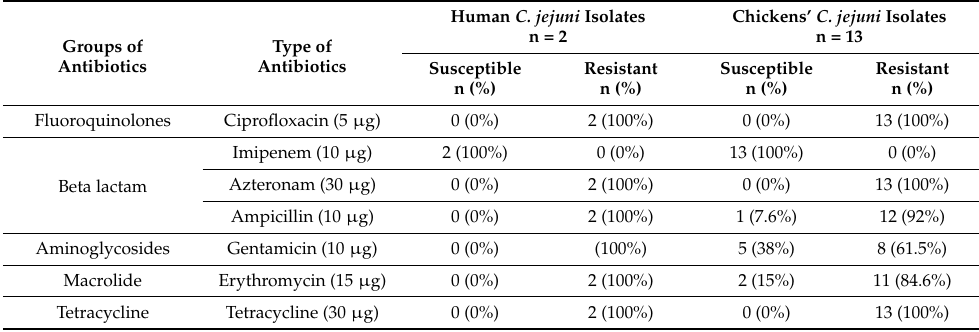
Table 3. Antimicrobial susceptibility percentages of Campylobacter jejuni isolated from poultry and human source to selected antibiotics.